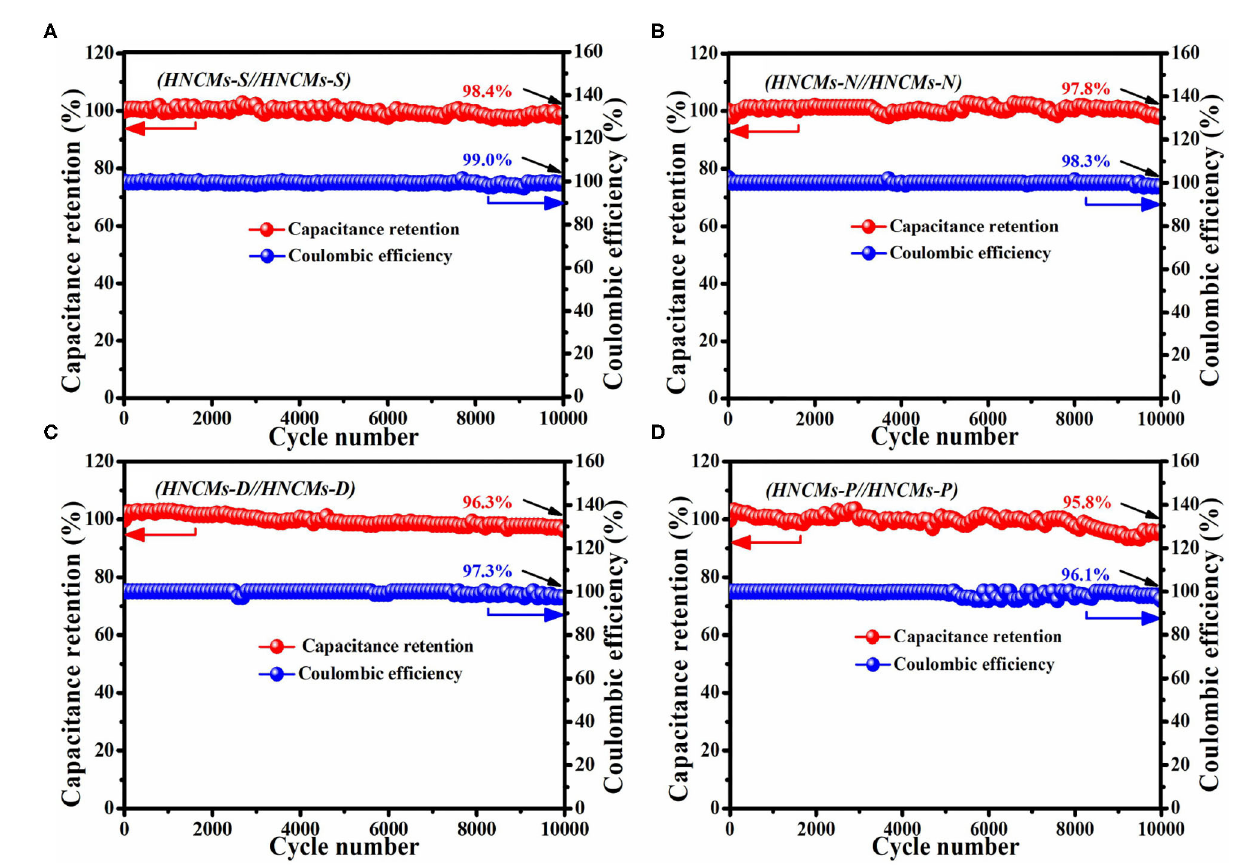
FIGURE 8 | The capacitance retention and coulombic efficiency of HNCMs-X//HNCMs-X supercapacitors at 1 A g − 1 over 10,000 cycles. (A) HNCMs-S//HNCMs-S, (B) HNCMs-N//HNCMs-N, (C) HNCMs-D//HNCMs-D, and (D)